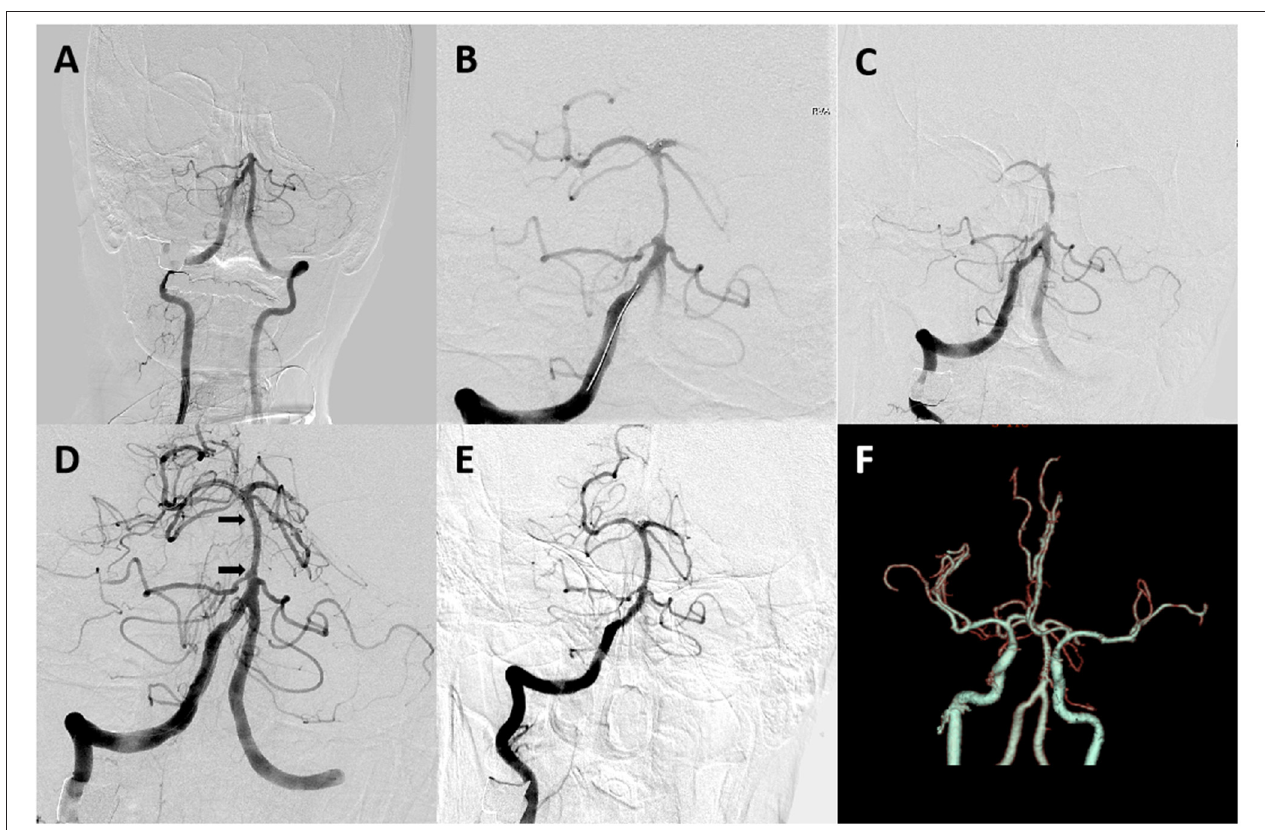
FIGURE 2 | A 62-year-old male patient with coronary artery disease for 20 years and hypertension for 3 years presented with disturbance of consciousness for 4h. (A) Digital subtraction angiography revealed occlusion at the proximal basilar artery segment. (B,C) Angiogram obtained after one Solitaire AB pass revealed severe underlying atherosclerotic stenosis of the proximal basilar artery segment. (D,E) Digital subtraction angiography after stent placement revealed good perfusion with fixed, focal basilar artery stenosis. Arrows indicate proximal and distal ends of the Apollo stent. (F) CT angiography on 24-h follow-up revealed a patent basilar artery. The patient had a modified Rankin scale (mRS) score of 3 on a 3-month follow-up.